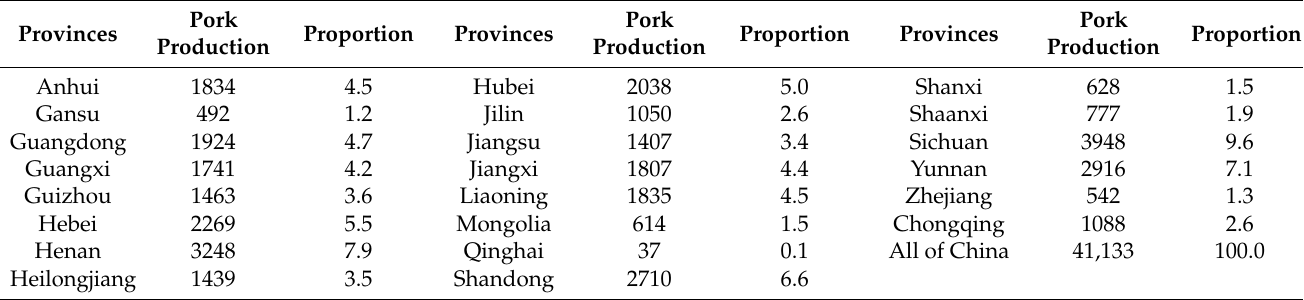
Table 1. Pork production and proportion in 22 sample provinces in 2020 (units: thousand tons;